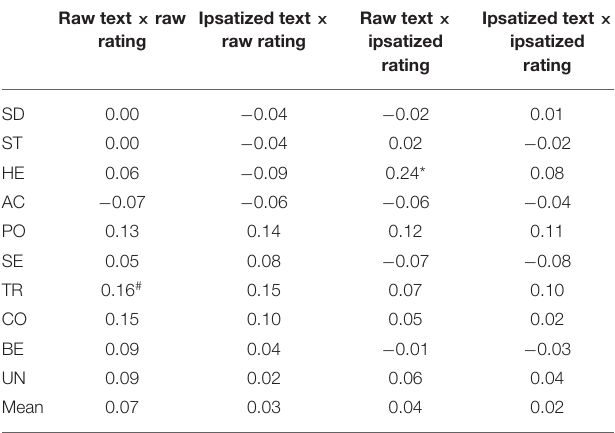
TABLE 2 | Overall similarity (correlation) of matching value types in Study